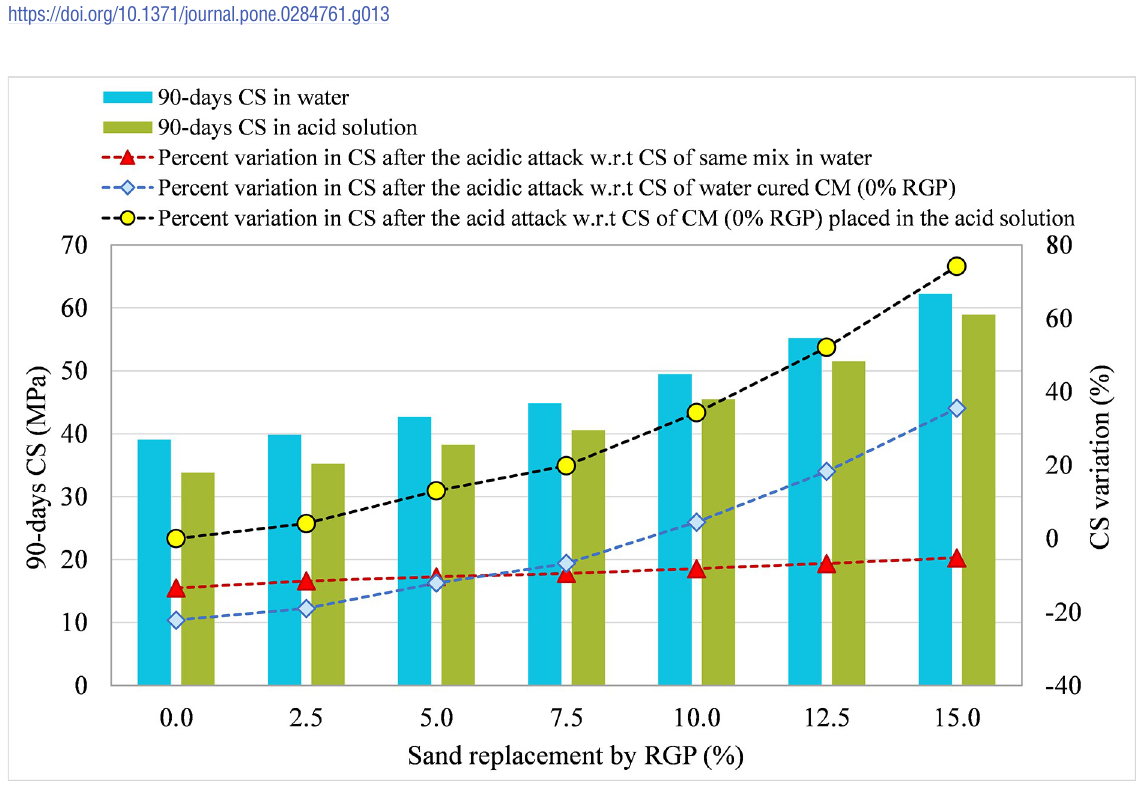
Fig 14. CS variation in samples placed in plain water and the acid solution for SF-20 mix incorporating RGP as a sand replacement.